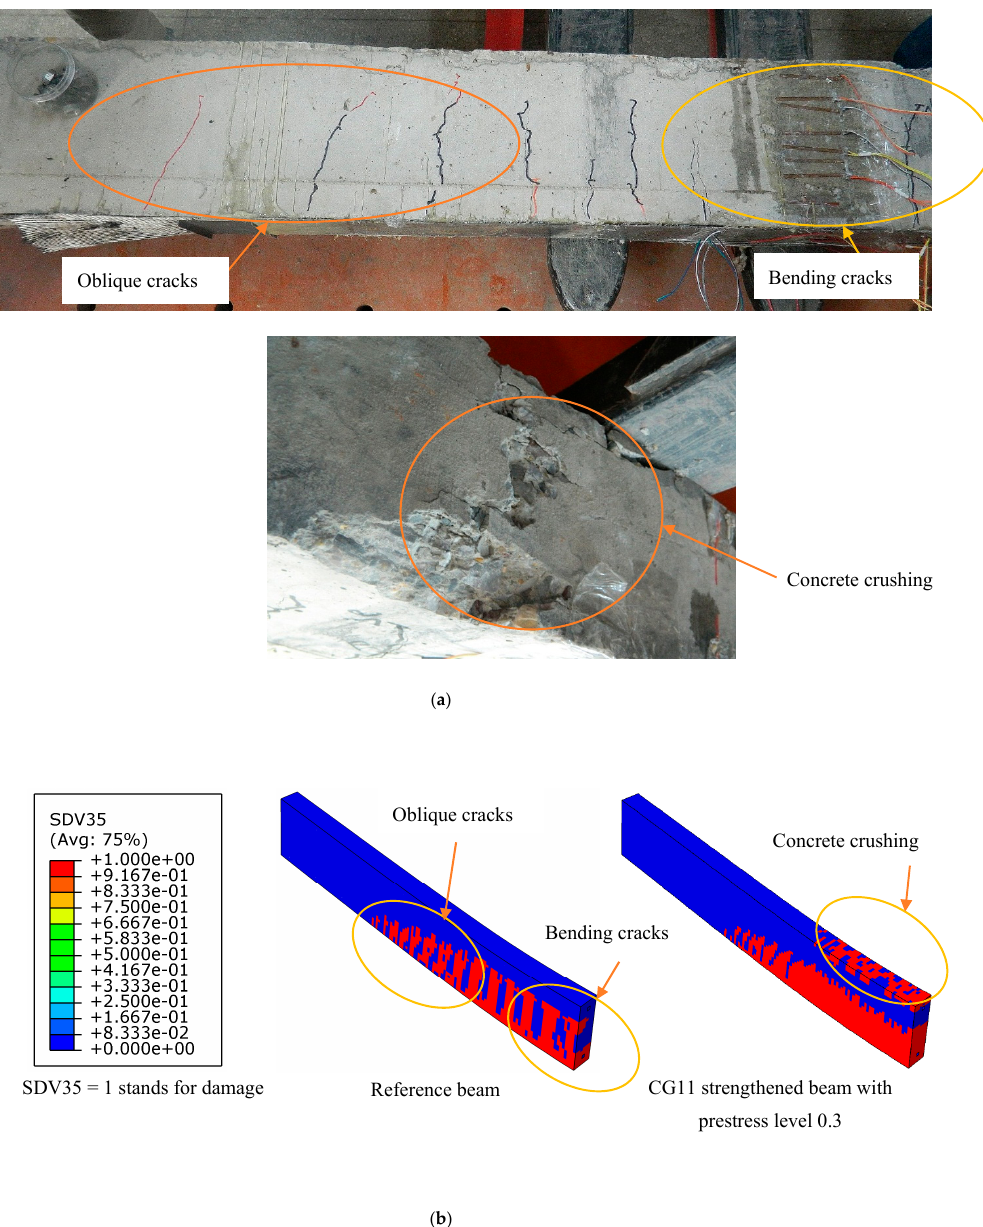
Figure 17. Crack distribution of the concrete of the reference beam and strengthened beam under ultimate load: ( a ) test results; ( b ) numerical simulation results.